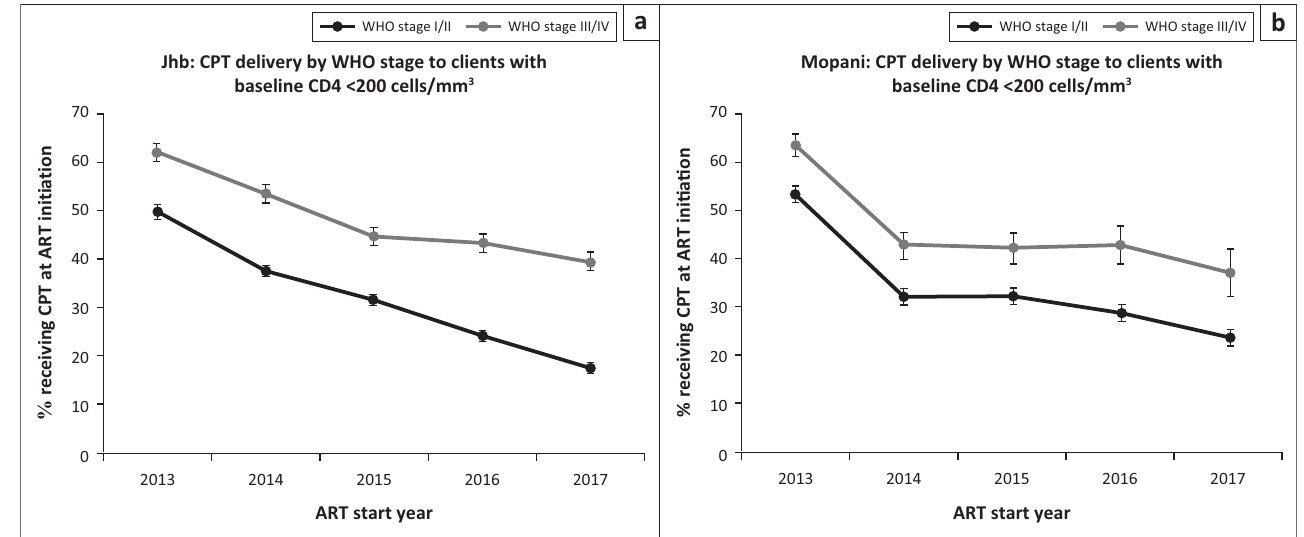
ART, antiretroviral therapy; CPT, cotrimoxazole preventive therapy; Jhb, Johannesburg district; WHO, World Health Organization. FIGURE 4: Delivery of cotrimoxazole preventive therapy over time to clients with baseline CD4 counts < 200 cells/mm 3 by clinical stage in (a) Johannesburg district and (b) Mopani